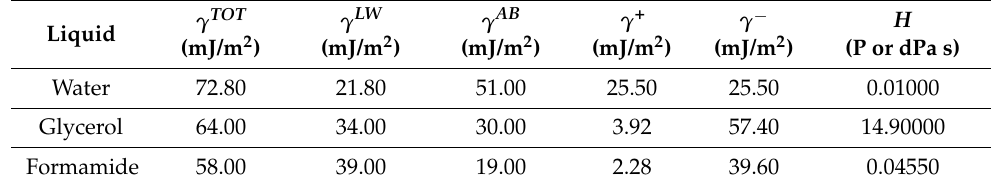
Table 3. Surface energy properties of contact angle liquids and their viscosities, η all at 20 ◦ C [33].